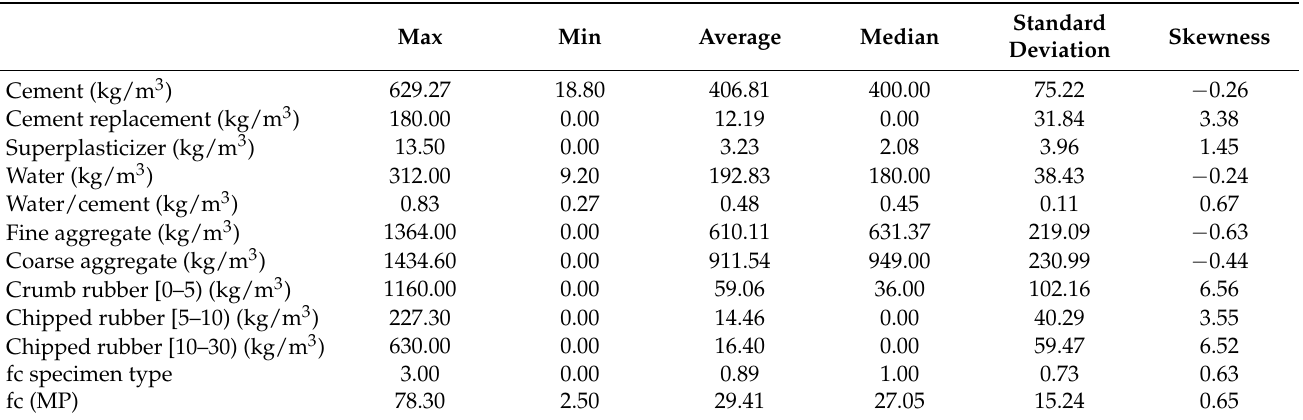
Table 1. Statistical analysis of input and output variables.